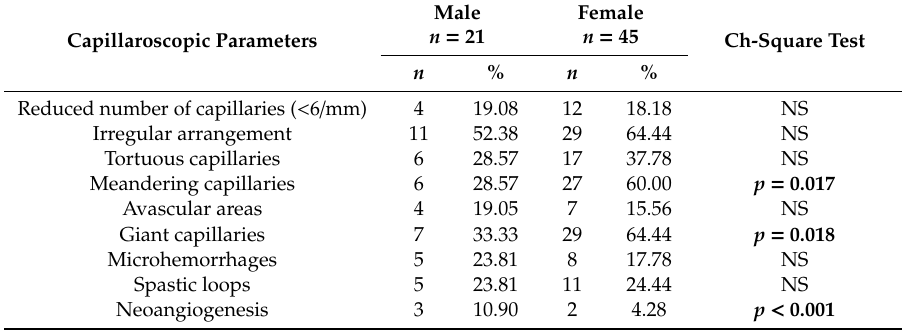
Table 2. Qualitative capillary parameters in the group of patients with RP in relation to gender.